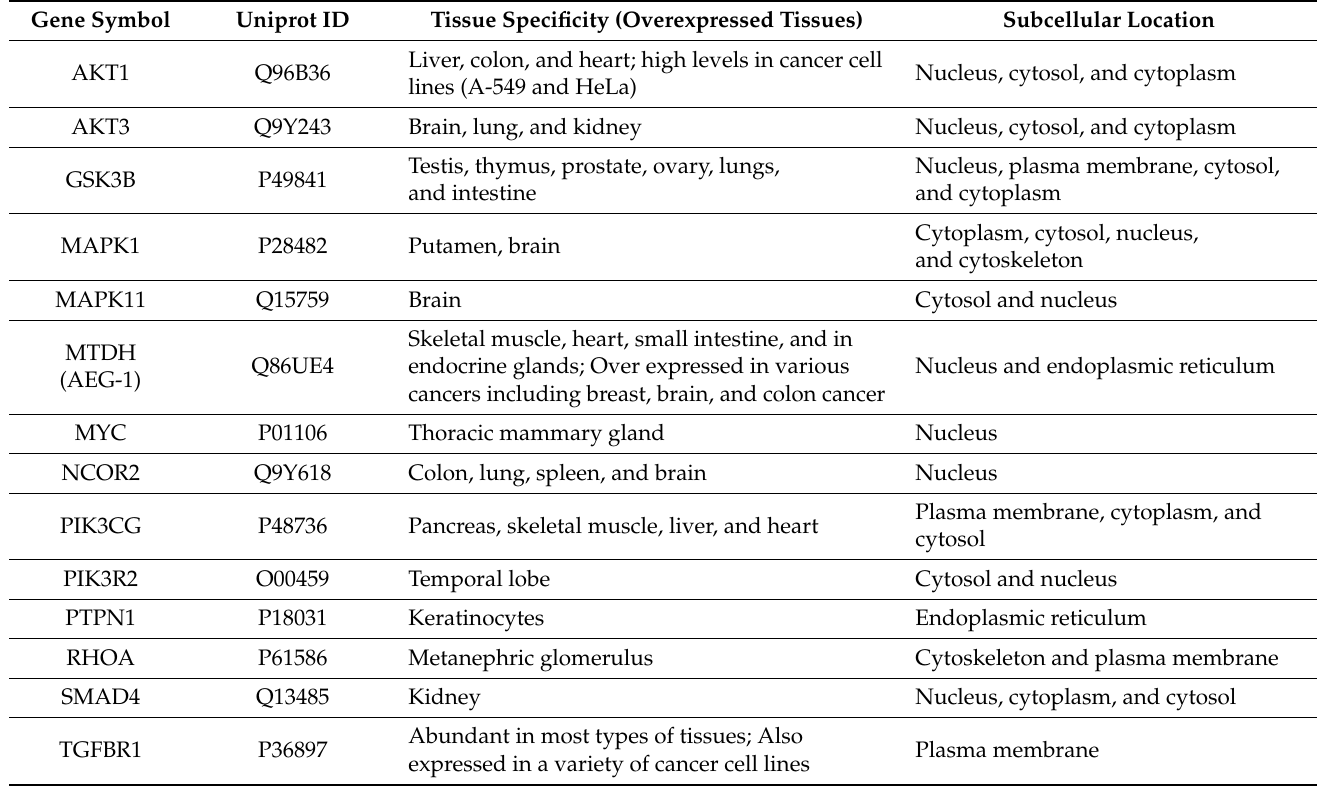
Table 1. Cellular topology and site of expression of miR-122 interactors.